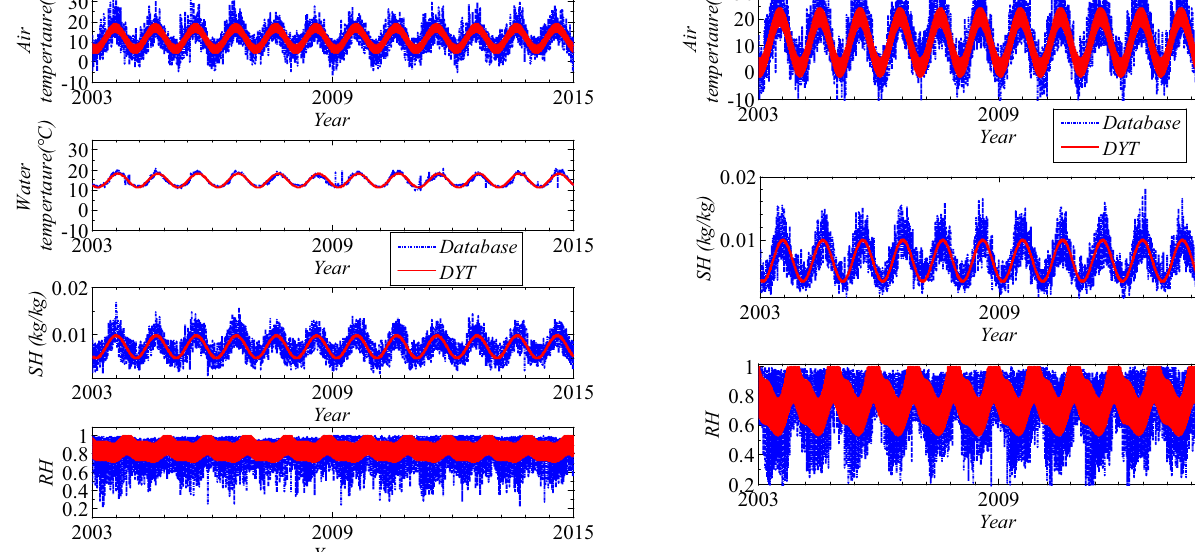
Fig. 3 Climate database and daily yearly-based climate model for